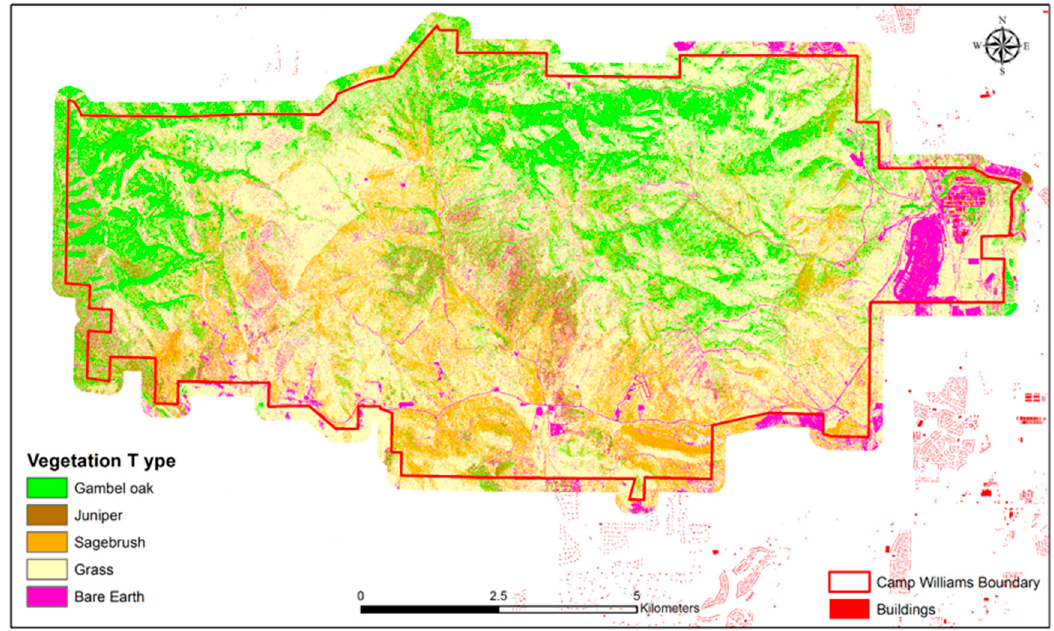
Figure 4. Spatial depiction of vegetation at Army Garrison Camp Williams predicted using random forests at 0.5 m resolution. Table 3. Matrix of vegetation class distribution within the National Fire Danger Rating System